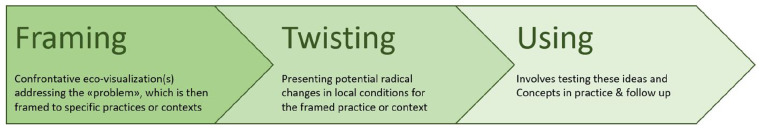
The three methodological pillars/phases.